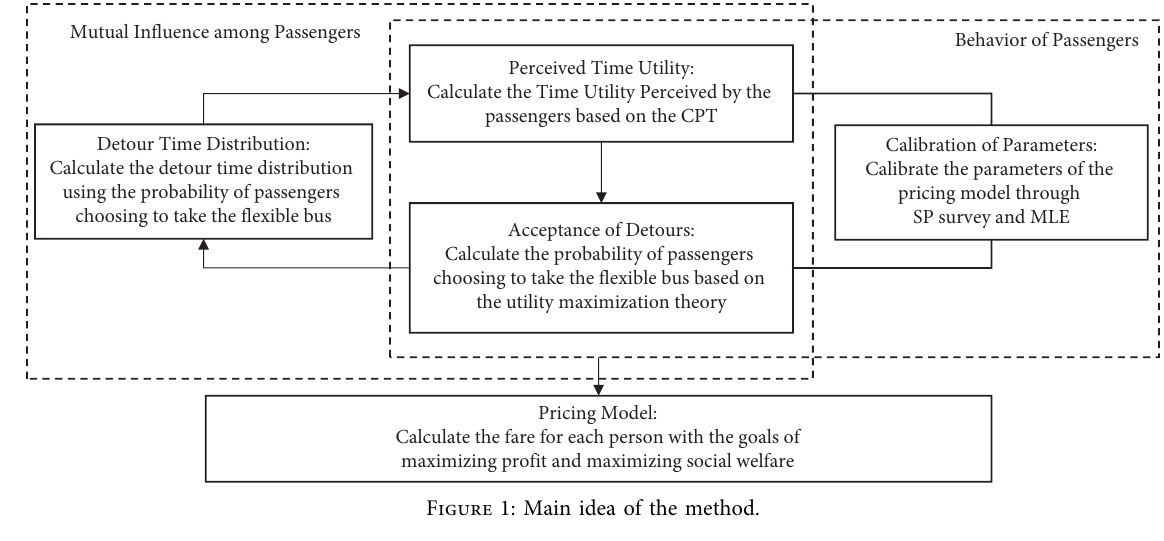
Figure 1: Main idea of the method.